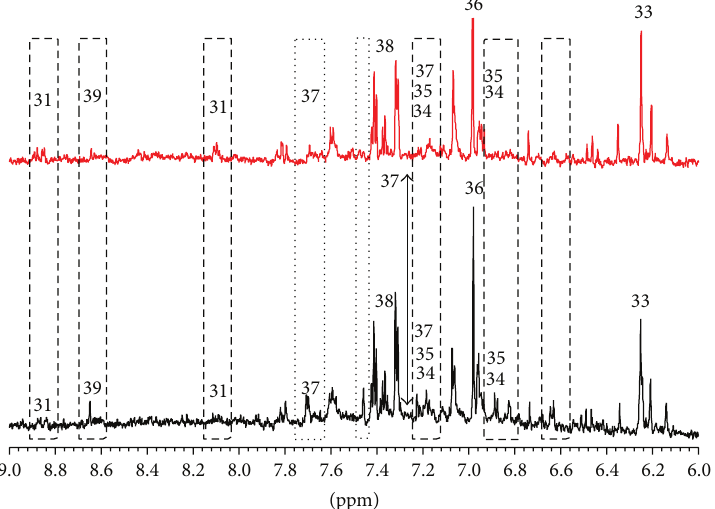
Figure 6: Comparison between the one-dimensional proton spectra of the lemon juice from PGI Interdonato lemon of Messina (red line) and Interdonato Turkish lemon (black line) in the region of phenolic compounds. 31: trigonelline, 33: nucleosides, 34: tyrosine, 35: tyramine, 36: gallic acid, 37: tryptophan, 38: phenylalanine, and 39: adenosine monophosphate